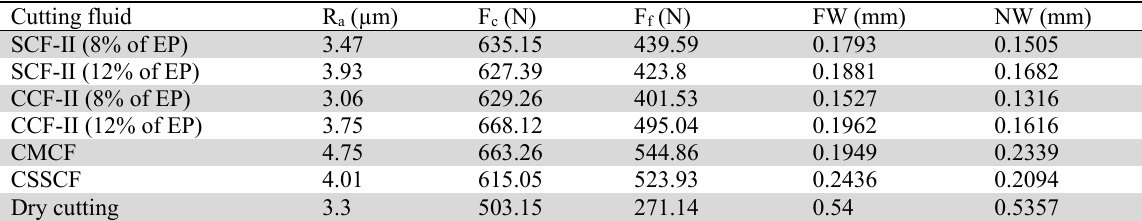
Decision matrix for case study 4 Tiwari and Sharma (2015) Cutting fluid